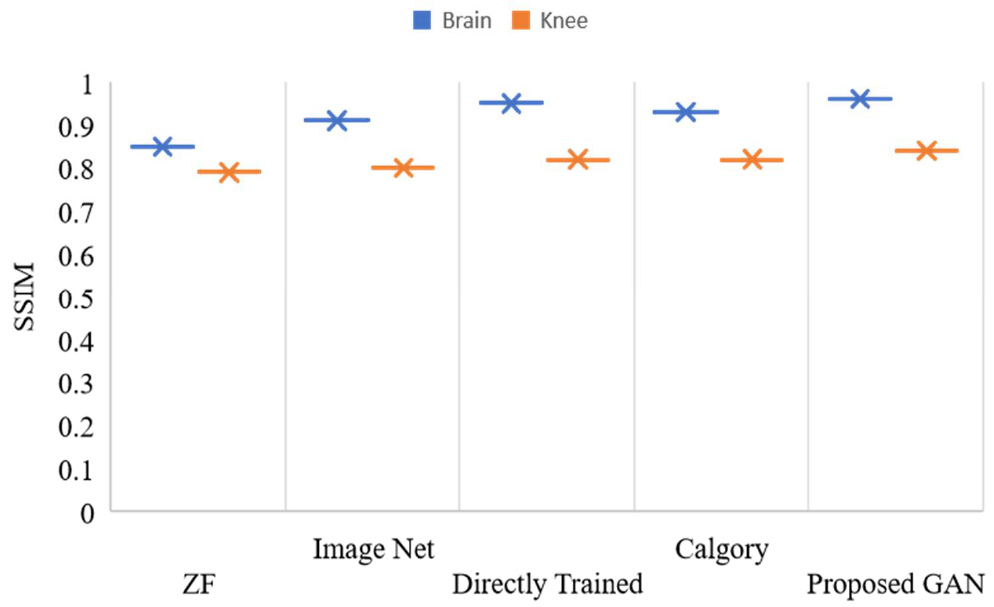
Figure 14. SSIM, values of reconstructed images of the knee and brain using various models, with AF = 4.